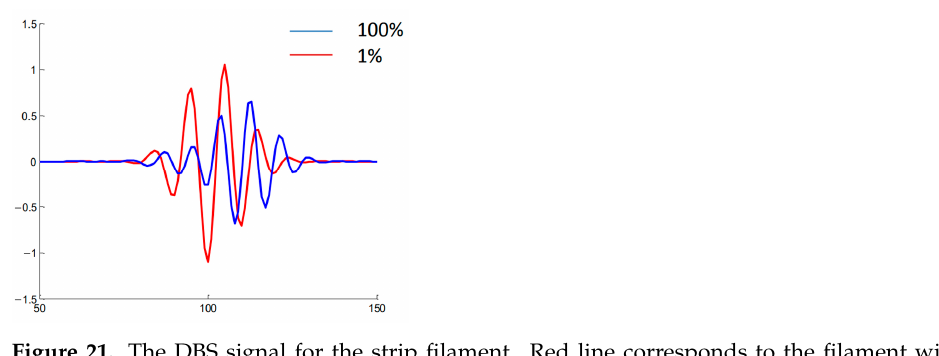
Figure 21. The DBS signal for the strip filament. Red line corresponds to the filament with an amplitude of 1% of density at cutoff of the probing wave 48 GHz where the filament was positioned, and the blue line corresponds to an amplitude of 100%.